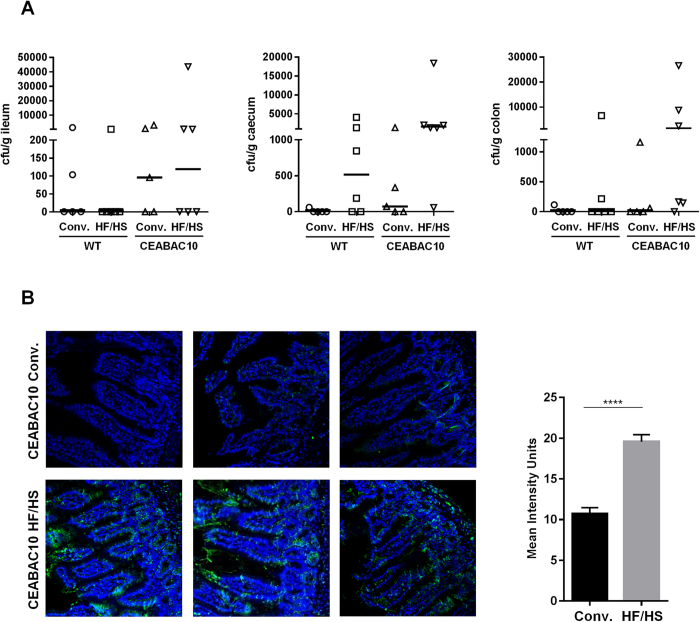
Western diet favors emergence of E. coli associated with ileal, cecal and colonic mucosa.(A) E. coli bacteria were isolated from the mucosa by plating on Drigalski agar plates and the number of bacteria was determined by counting the CFU. (B) E. coli colonization of the ileal mucosa of CEABAC10 mice under a conventional or an HF/HS diet was visualized by confocal microscopy and quantification was performed by assessing global fluorescence intensities using the ImageJ software. ****P < 0.0001.